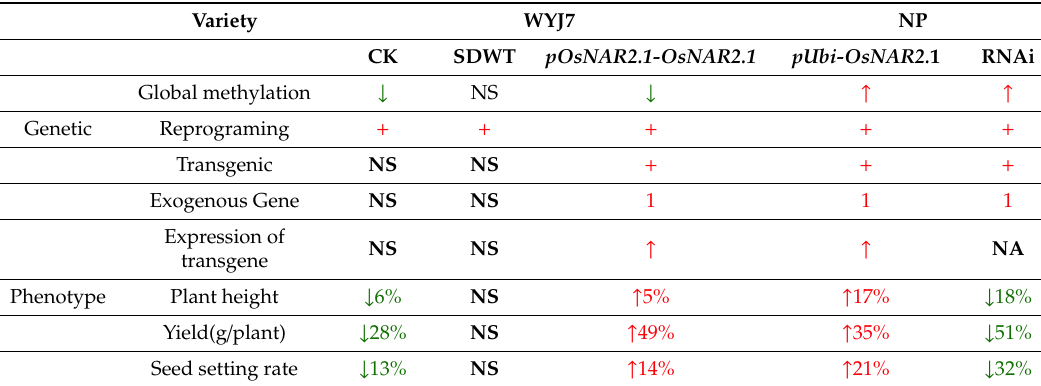
Figure 4. Characteristics of phenotype ( a ) Gross morphology of WYJ7, CK, SDWT and pOsNAR2.1-OsNAR2.1. ( b ) Real-time quantitative RT-PCR analysis of OsNAR2.1 expression in WYJ7, CK, SDWT and pOsNAR2.1-OsNAR2.1 lines. Error bars: SD ( n = 3 plants). ( c ) Grain yield for WYJ7, CK, SDWT and pOsNAR2.1-OsNAR2.1 plants grown in the field. Error bars: SD ( n = 5 plants). Significant di ff erences between WYJ7 and transgenic lines are indicated by di ff erent letters (P < 0.05, one-way ANOVA). ( d ) Seed setting rate for WYJ7, CK, SDWT and pOsNAR2.1-OsNAR2.1 plants grown in the field. Error bars: SD ( n = 5 plants). Significant di ff erences between WYJ7 and transgenic lines are indicated by di ff erent letters ( p < 0.05, one-way ANOVA). ( e ) Gross morphology of wild-type of NP, pUbi-OsNAR2.1 and RNAi. ( f ) Real-time quantitative RT-PCR analysis of OsNAR2.1 expression in NP, pUbi-OsNAR2.1 and RNAi lines. Error bars: SD ( n = 3 plants). ( g ) Grain yield for NP, pUbi-OsNAR2.1 and RNAi plants grown in the field. Error bars: SD ( n = 5 plants). Significant di ff erences between NP and transgenic lines are indicated by di ff erent letters ( p < 0.05, one-way ANOVA). ( h ) Seed setting rate for NP, pUbi-OsNAR2.1 and RNAi plants grown in the field. Error bars: SD ( n = 5 plants). Significant di ff erences between NP and transgenic lines are indicated by di ff erent letters ( p < 0.05, one-way ANOVA). Table 2. Characteristics of methylation and genetics in